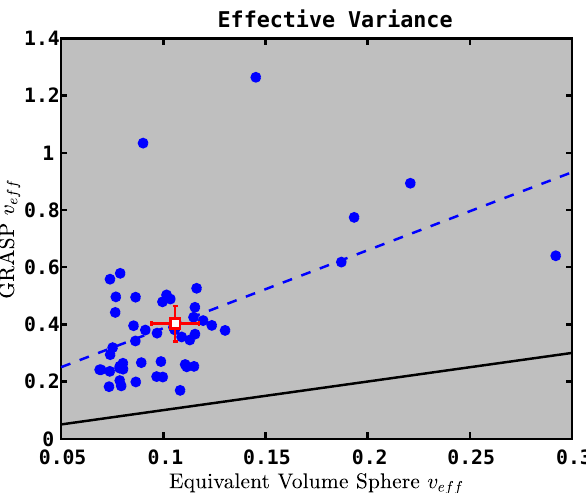
Figure 10. GRASP effective variance (subsampled to an equivalent solar zenith angle of 50 ◦ ) vs. APS equivalent volume variance using variable dynamic shape factors or densities for the conversion from aerodynamic size to equivalent volume size. Red square and error bars represent means and two standard deviations of the means for the blue points. Solid line is 1:1 and dashed line represents linear regression; see Table 3 for regression